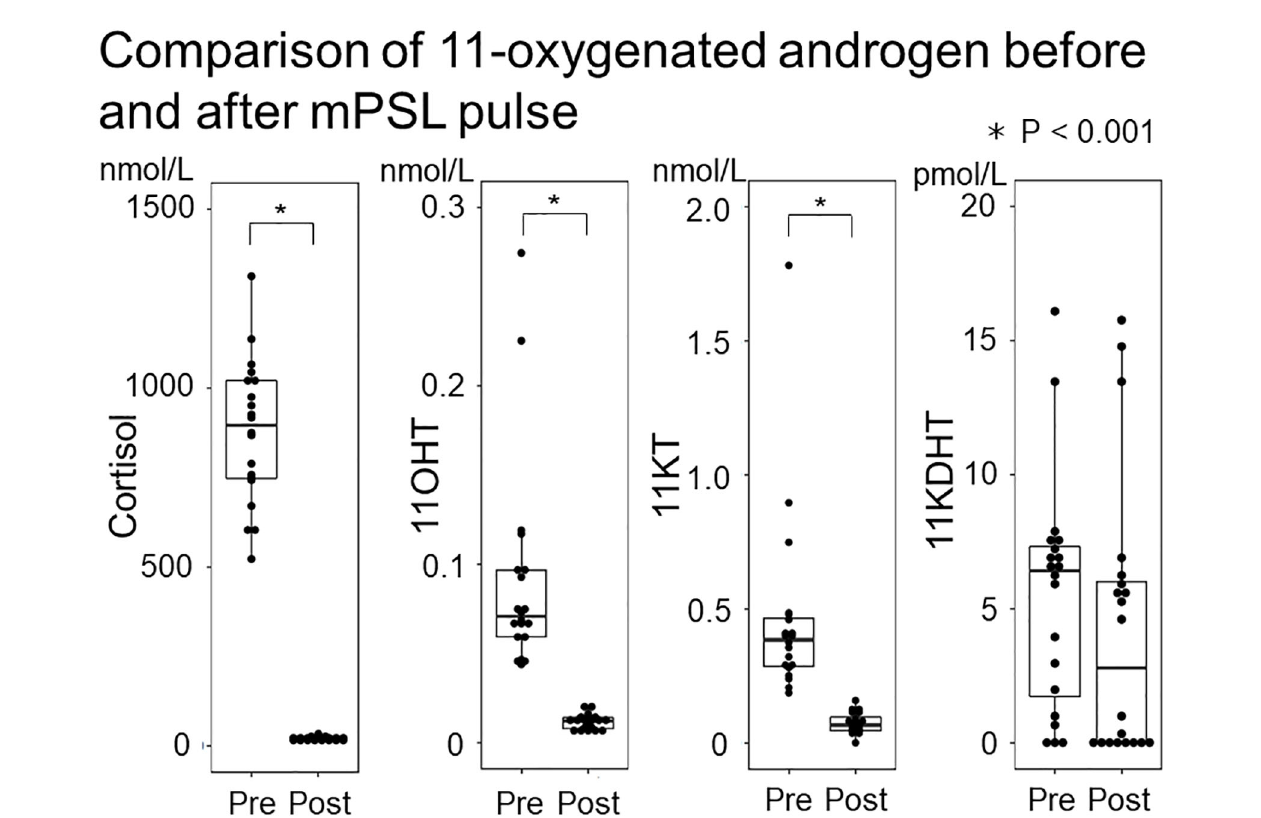
FIGURE 2 Comparison of 11-oxygenated androgen before and after mPSL pulse. The 11-oxygenated androgen values before and after mPSL pulse were compared. Serum cortisol, 11OHT, and 11KT were signi fi cantly lower after mPSL pulse.